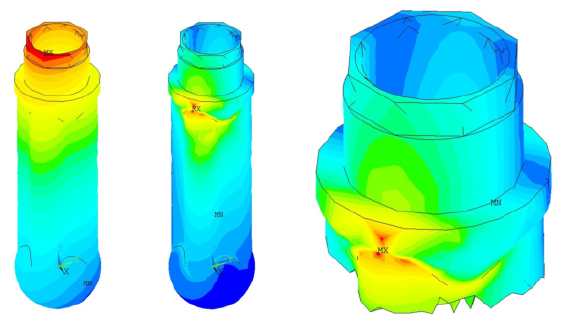
Figure 3. Numerical analysis of the reference implant 0001: displacement – u von Mises stress – σ